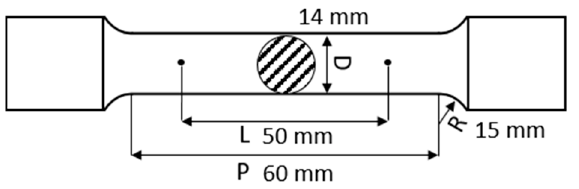
Figure 2. Specifications of the specimen used for the tensile test . D: Original cross-sectional area of parallel length; L: Original gauge length; R: Transition radius; P: Parallel parallel length; L: Original gauge length; R: Transition radius; P: Parallel length. The hardness of the specimen was measured using the Brinell hardness test method.